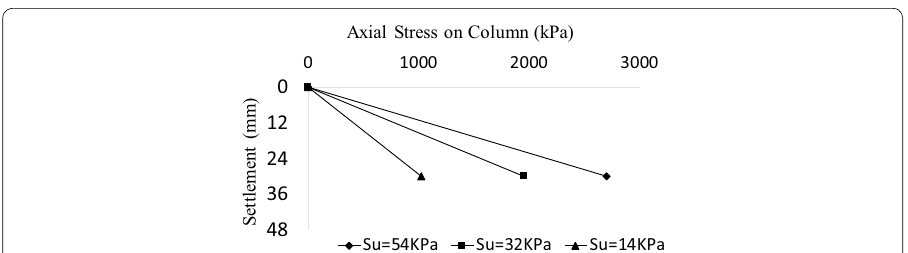
Fig. 15 Effect of shear strength on the axial capacity of sand columns